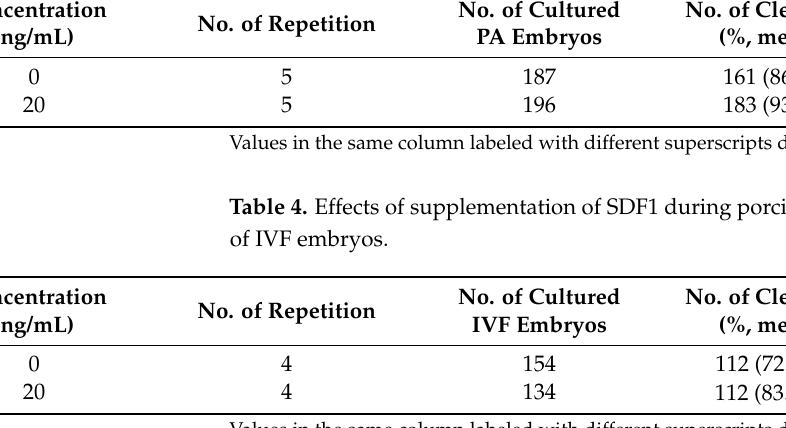
Table 3. Effects of supplementation of SDF1 during porcine oocyte IVM on subsequent development of PA embryos.